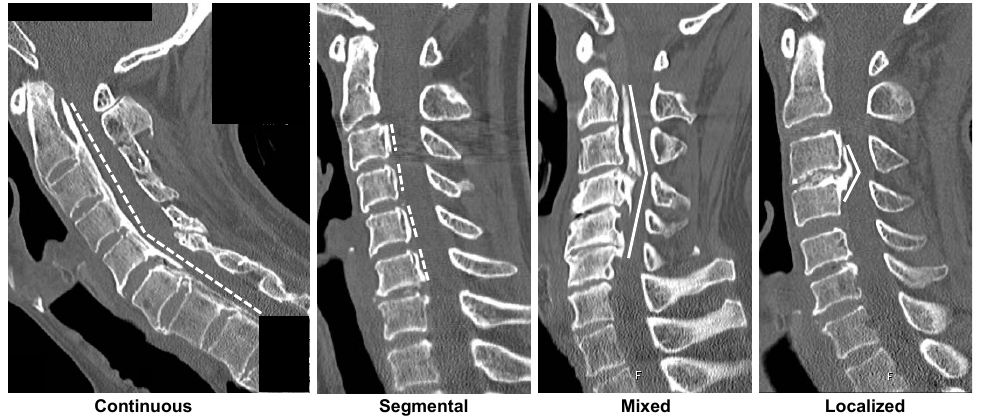
Figure 1. Representative OPLL type and OPLL shape. Plateau shapes are marked with dashed lines and indicate the relatively narrow spinal canal without any localized massive ossification. Hill shapes are marked with solid lines, defined by a massive beak-shaped ossification localized to certain levels [16]. The radiographs display (from left to right) plateau-shaped ossification in the continuous type OPLL, plateau-shaped segmental type OPLL, hill-shaped ossification in a beak configuration, and hill-shaped circumscribed type OPLL. OPLL, ossification of the posterior longitudinal ligament.